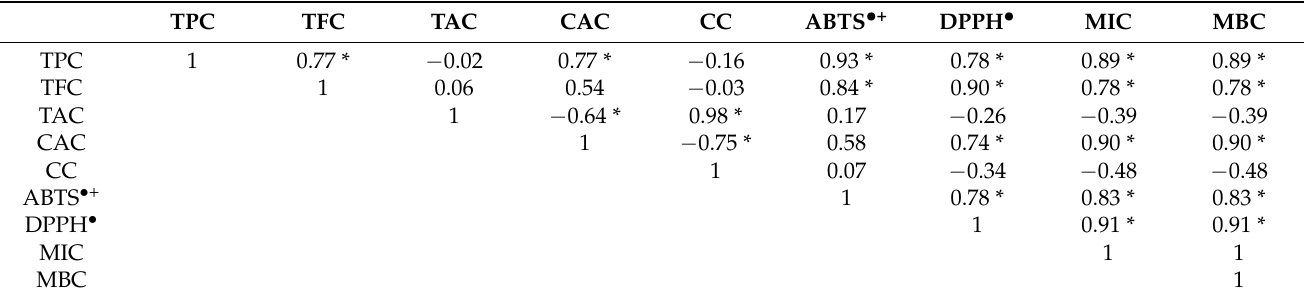
Table 8. Correlation coefficient between quantifications and biological activity of Vaccinium stenophyl- lum Steud. fruit